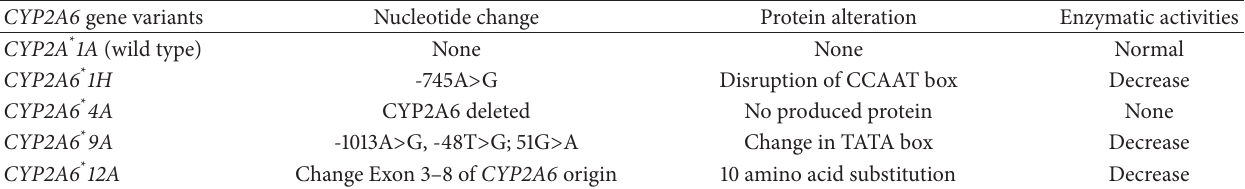
Table 1: Example of CYP2A6 gene variants structures and related enzymatic activities in nicotine